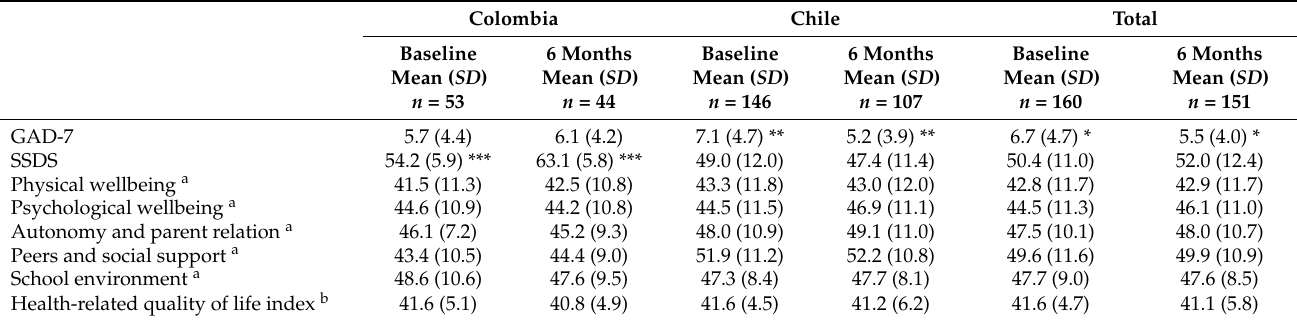
Table 3. Secondary outcomes at baseline and at 6